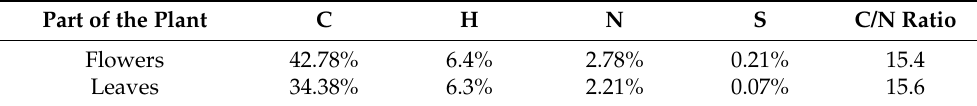
Table 1. Elemental (CHNS) composition (wt.%) of flowers and leaves of Hibiscus syriacus